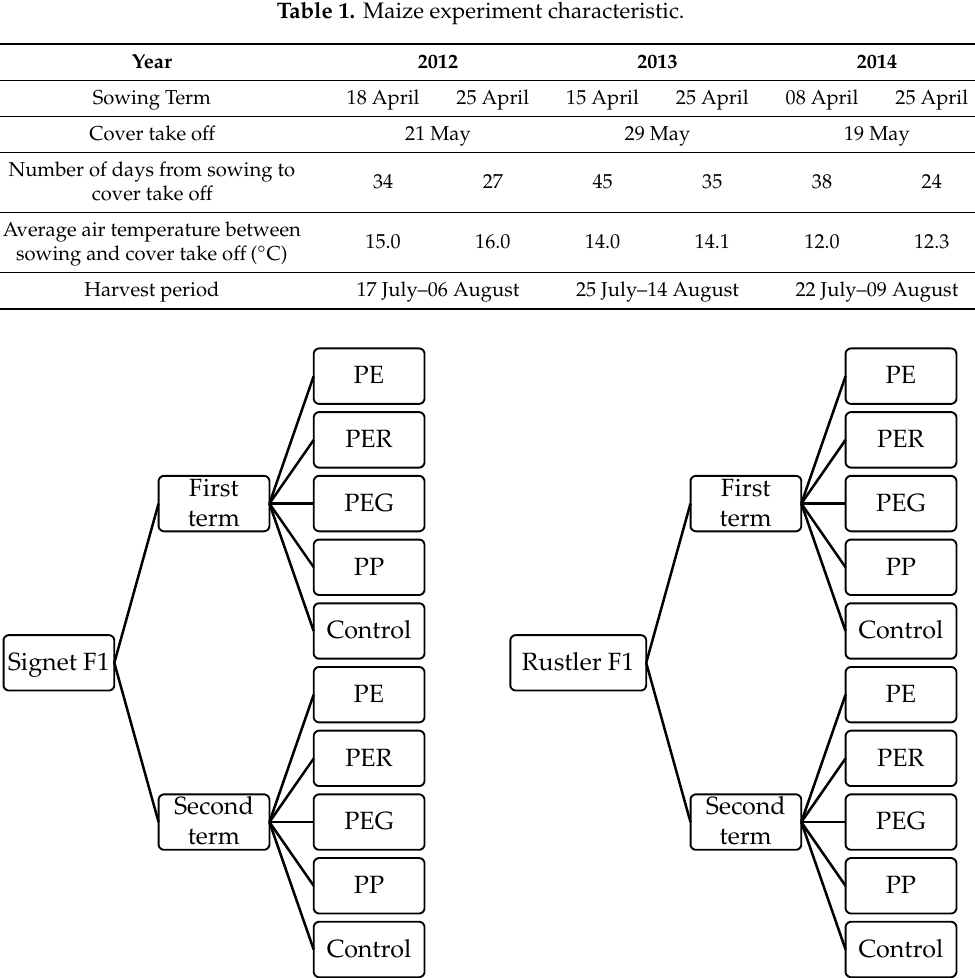
Figure 1. Field experiment layout. PE—polyethylene foil (colourless); PER—red polyethylene foil; PEG—green polyethylene foil; PP—non-woven fabric; Control—without cover.